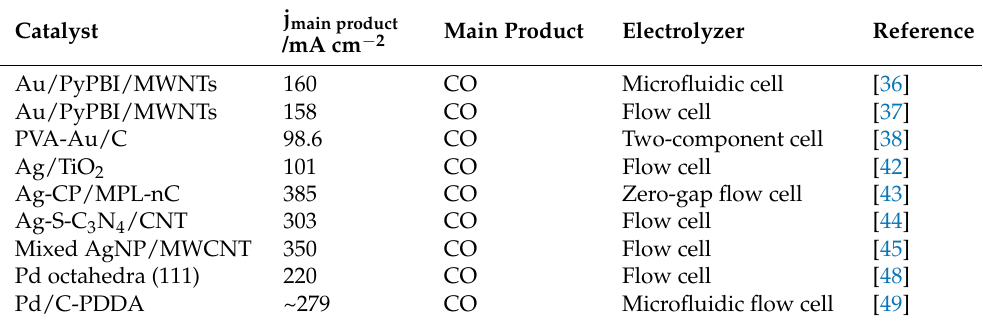
Table 2. CO 2 electroreduction performances of noble metal